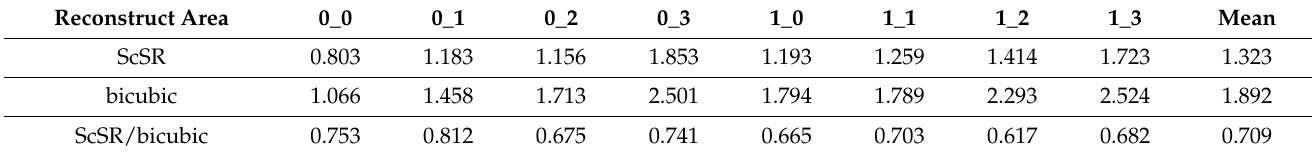
Table 1. RMSEs for eight regions reconstructed using the dictionaries learned in the other seven other sea areas, the RMSEs for bicubic interpolation, and their ratio. The unit of RMSE is metre in this